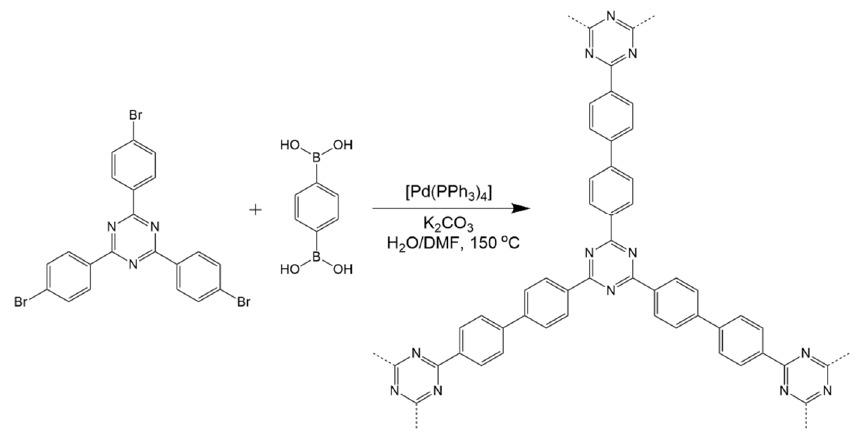
Figure 8. Polymerization of TTPT via Friedel–Crafts alkylation [29].